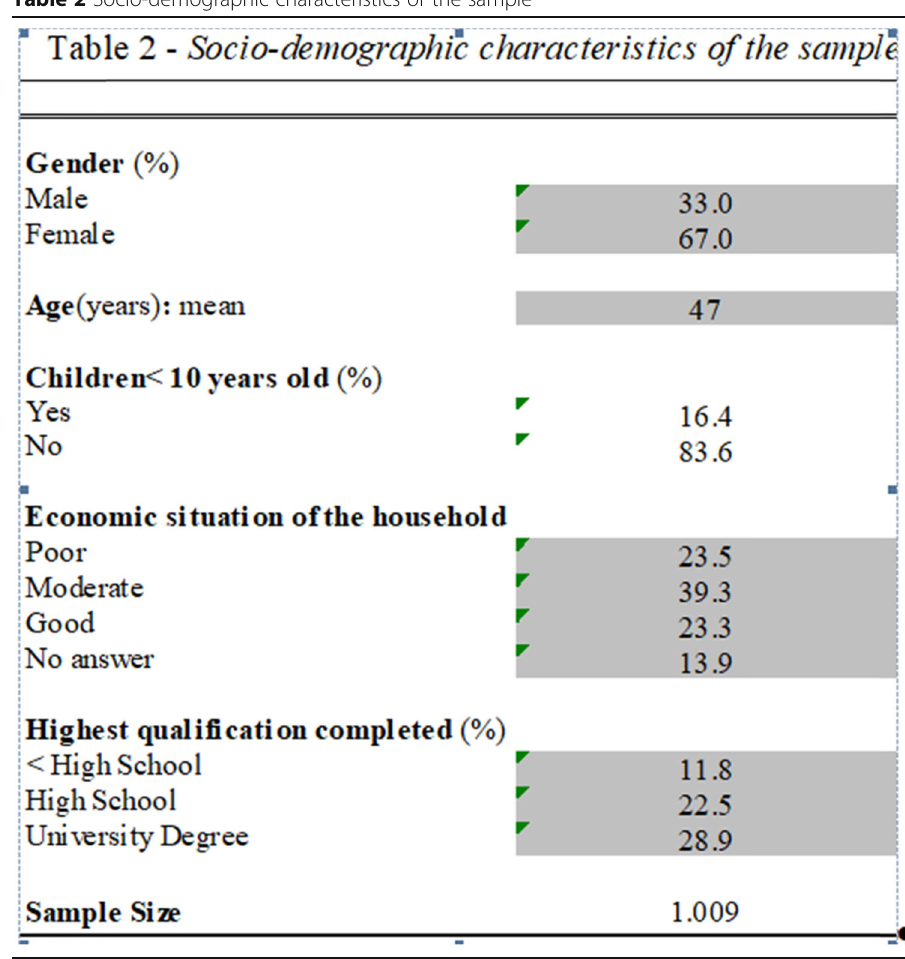
Table 2 Socio-demographic characteristics of the sample